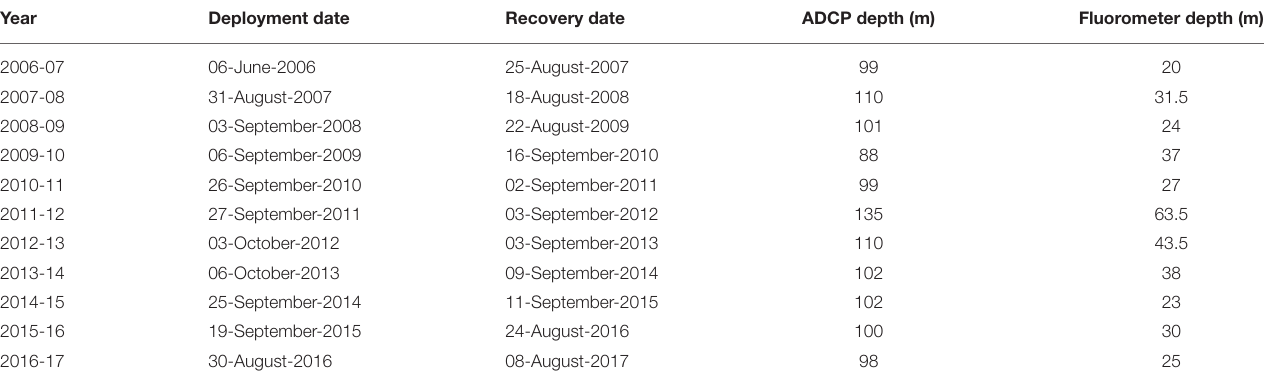
TABLE 1 | Details of mooring deployments, including dates of deployment and recovery of the mooring platform, and depth of Acoustic Doppler Current Profiler (ADCP) and fluorometry instrumentation.